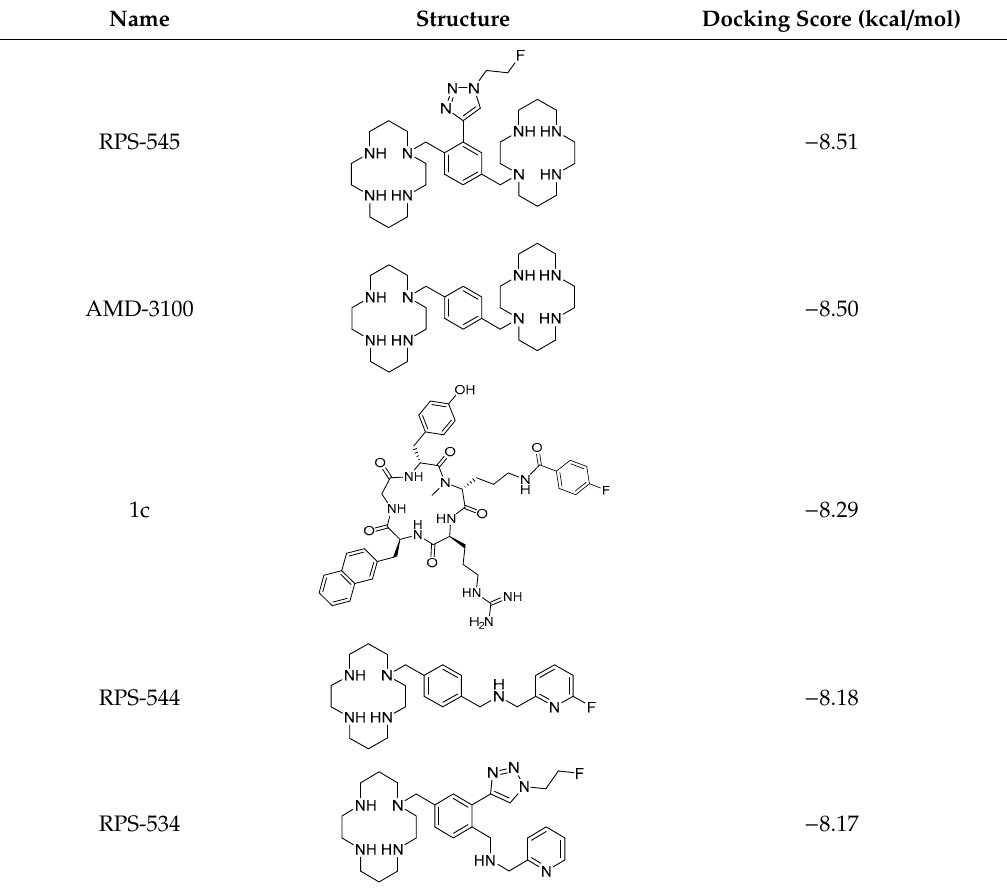
Table 1. Comparison of docking scores of six candidate CXCR4 ligands with known ligands with high affinity. Docking score was determined in an extra precision screen against human CXCR4 (PDB ID: 3ODU) using Schrodinger. The highest docking score is reported for each compound.